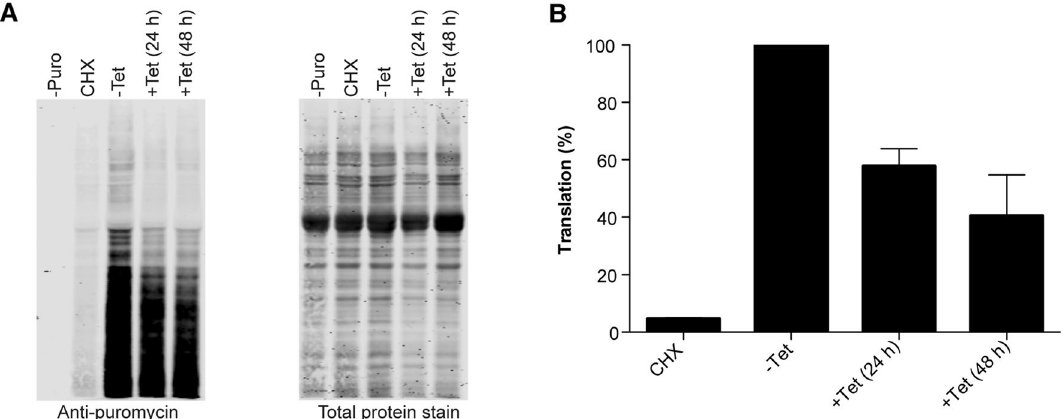
Figure 5. Depletion of Hel66 inhibits protein synthesis ( A ) Left: Western blot showing puromycin incorporation into proteins after the SUnSET assay. -Puro = uninduced cells with no puromycin treatment, CHX = uninduced cells treated with cycloheximide (inhibitor of translation) 30 min prior to treatment with puromycin, -Tet = uninduced cells treated with puromycin, + Tet (24 h) = cells treated with puromycin after 24 h of RNAi induction, + Tet (48 h) = cells treated with puromycin after 48 h of RNAi induction. Right: Total protein stain used as a loading control. ( B ) Quantification of the amount of puromycilated peptides (translation) from the western blot. The experiment was carried out with three different clonal cell lines and the mean values are shown ±